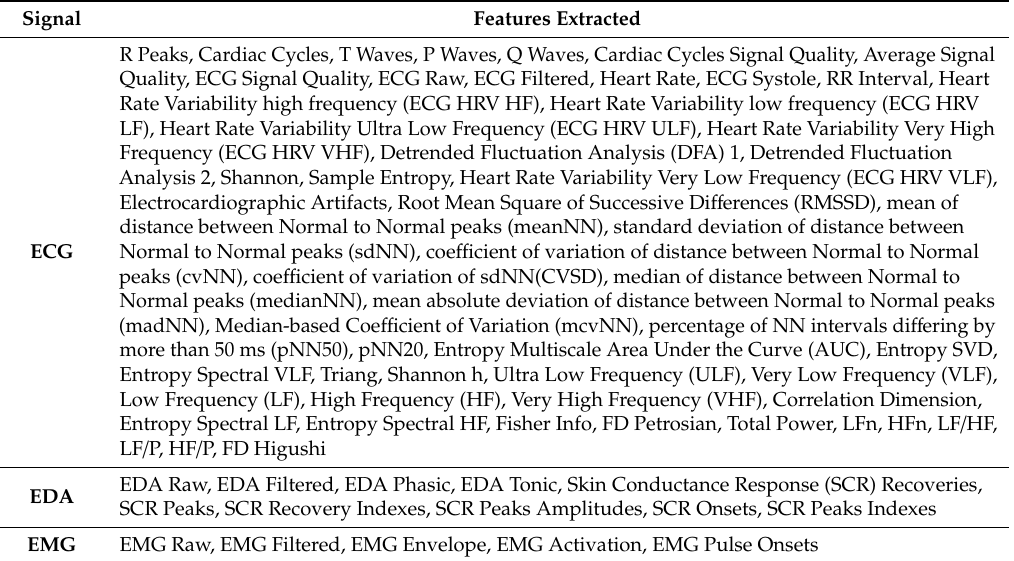
Table 1. Extracted features from collected biosignals: electrocardiogram (ECG), electromyogram (EMG), electrodermal activity (EDA).